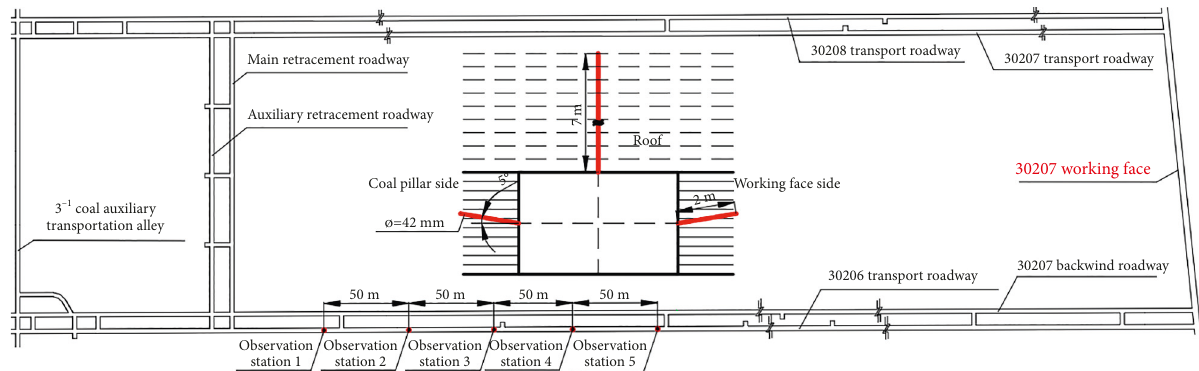
Figure 5: Loose ring peep location and peephole arrangement cross-sectional view.